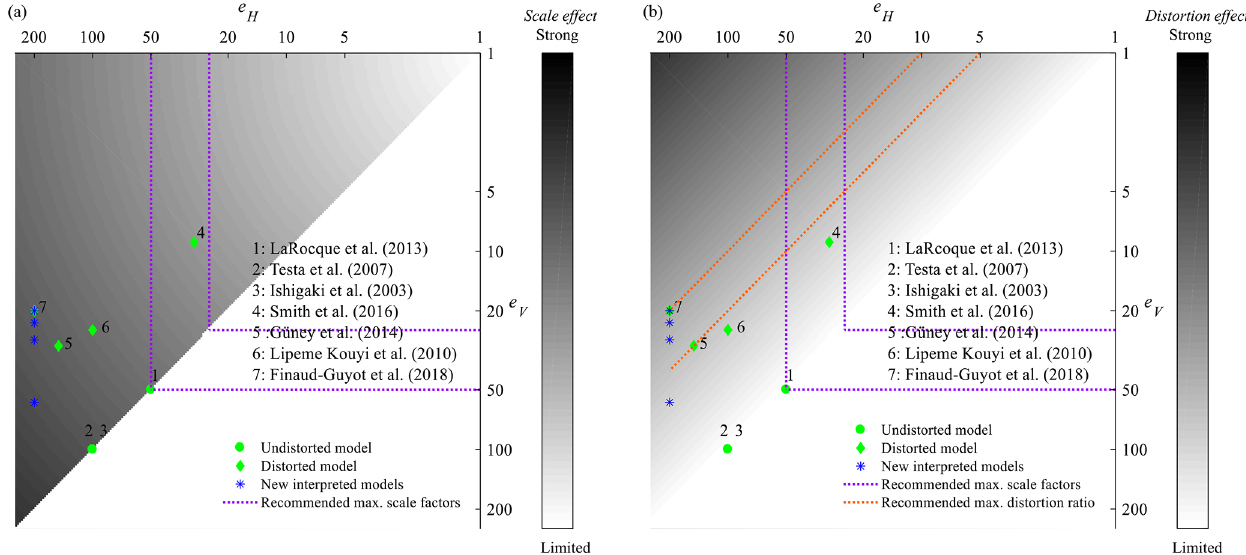
Figure 1. Recent laboratory models of urban flooding at the district level as a function of the horizontal and vertical scale factors, e H and e V . The grey shading qualitatively reveals the possible magnitude of (a) scale effects and (b) distortion effects; a range of maximum scale factors (purple lines) and distortion ratio (orange lines) were recommended by Chanson